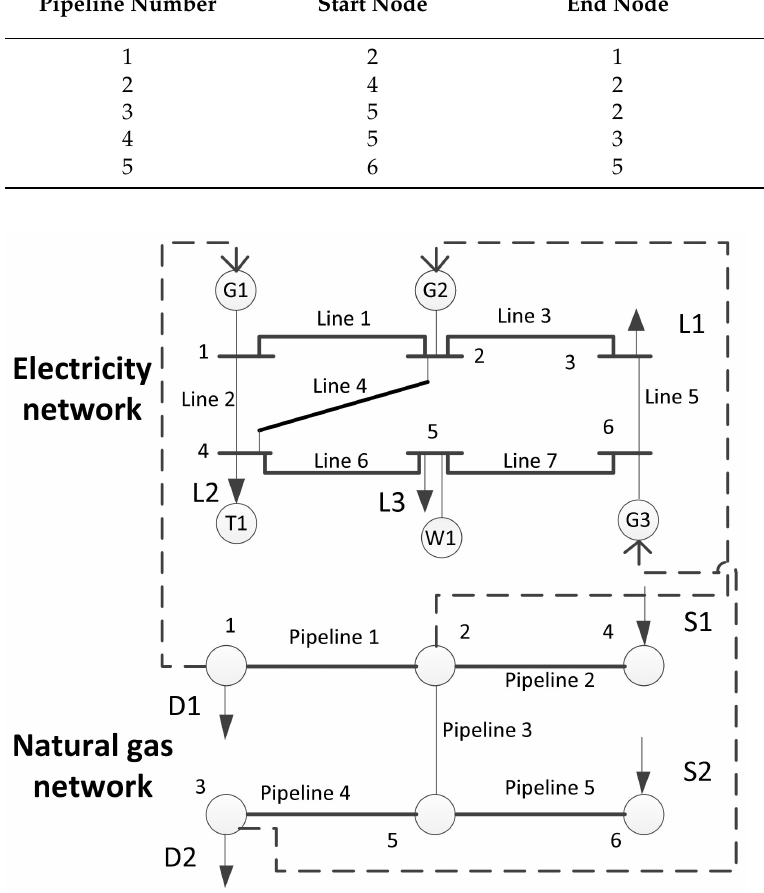
Figure 6. The topology of electricity and natural gas